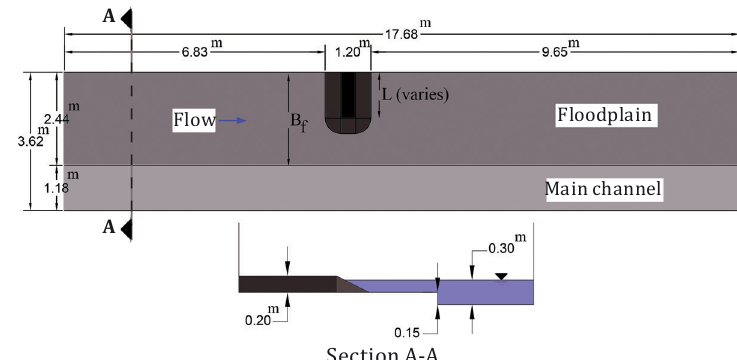
Figure 3. Plan and cross-section of Morales & Ettema’s (2013) laboratory Section A-A